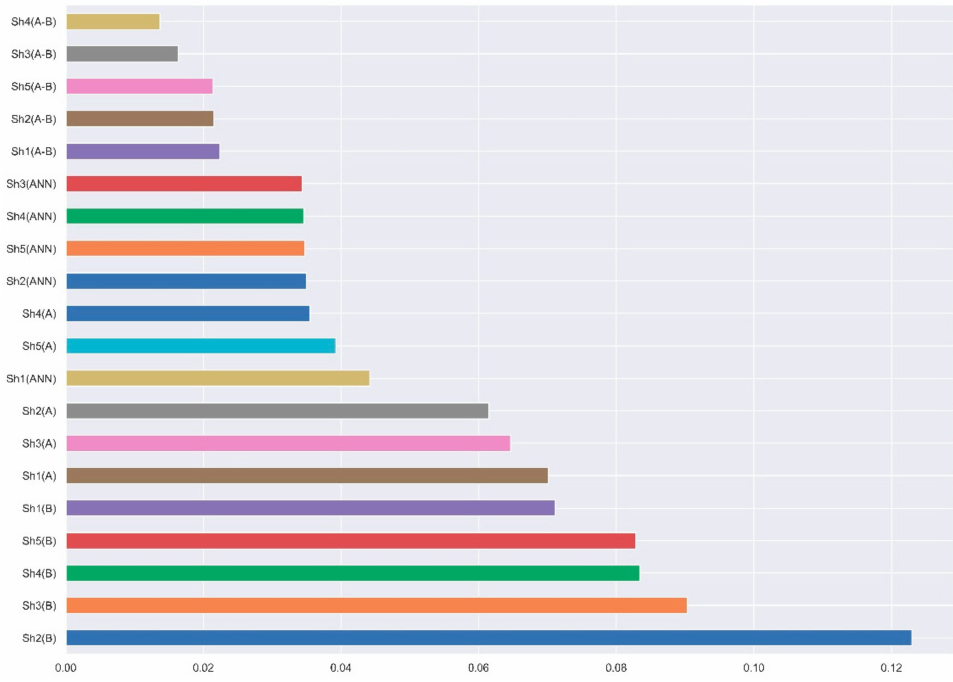
Figure 4. Feature importance for the best Random Forest